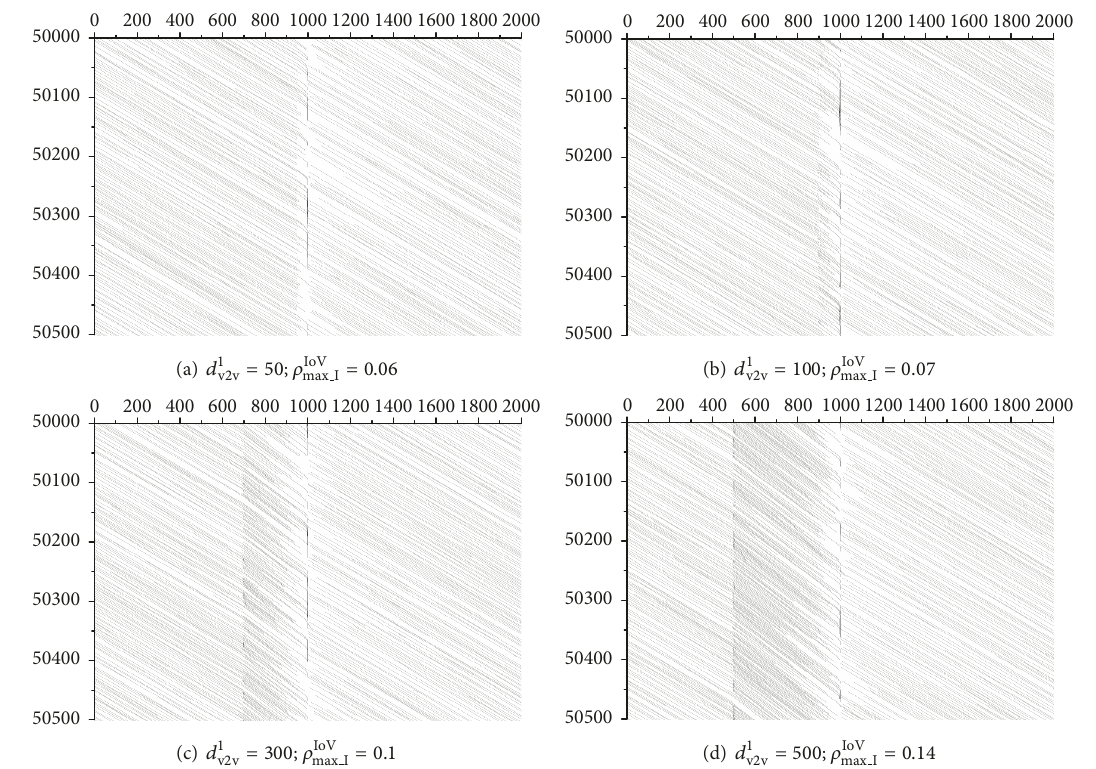
Figure 9: Spatiotemporal diagrams of different 𝑑 1